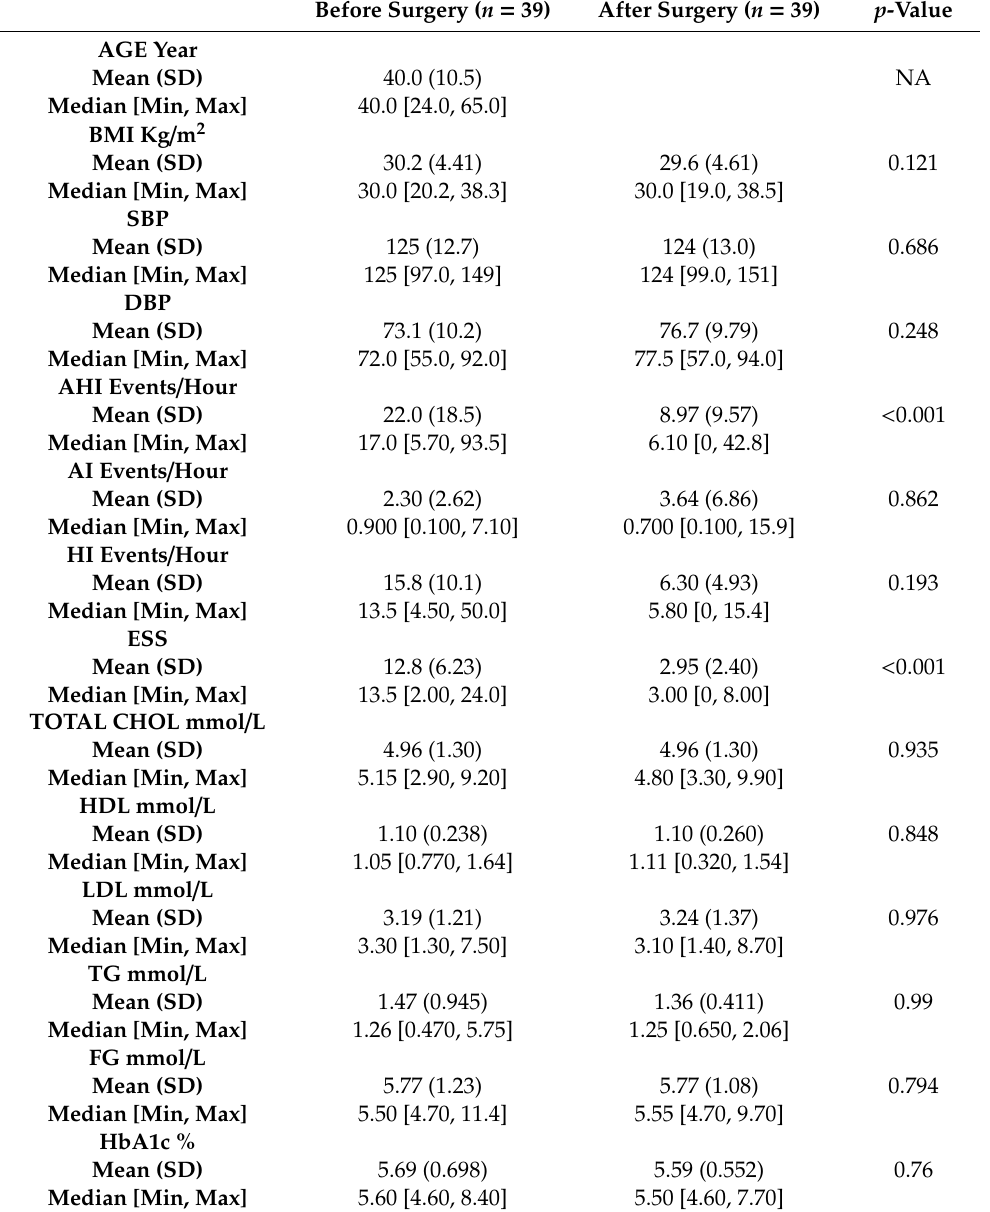
Table 1. Characteristics of all people included in the study before and after surgery. Before Surgery ( n = 39) After Surgery ( n = 39) p